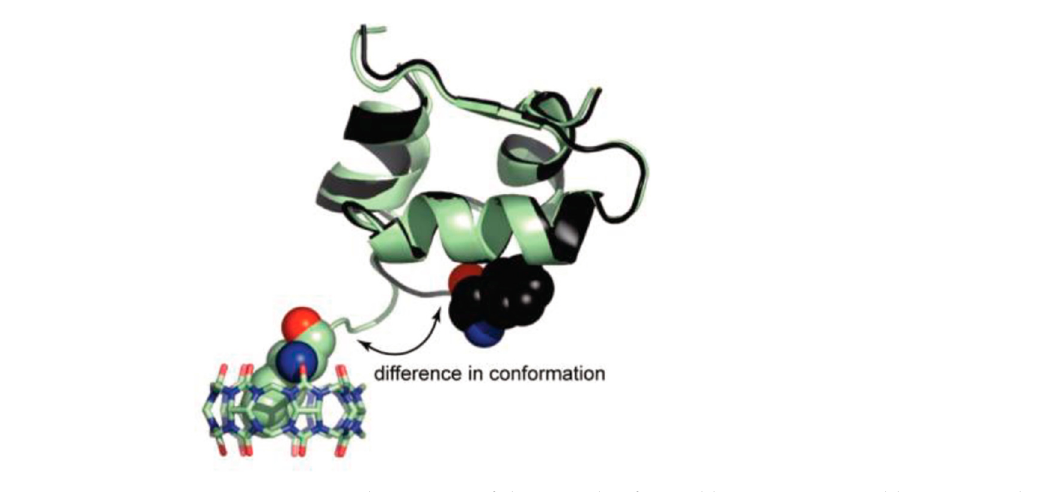
Figure 22. Crystal structure of the complex formed between CB7 and human insulin (light green) and of free insulin (black). Reprinted with permission from [124]. Copyright (2011) American Chemical Society.